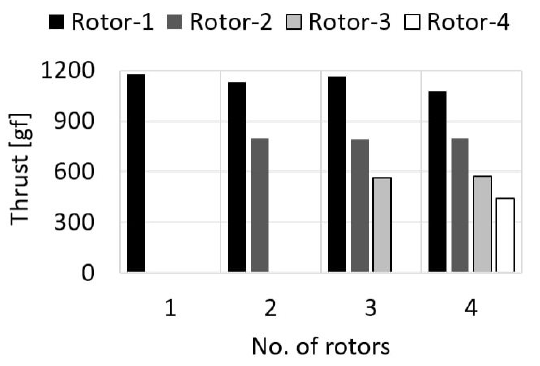
Figure 12. Thrust distribution among rotors for one to four-rotor coaxial